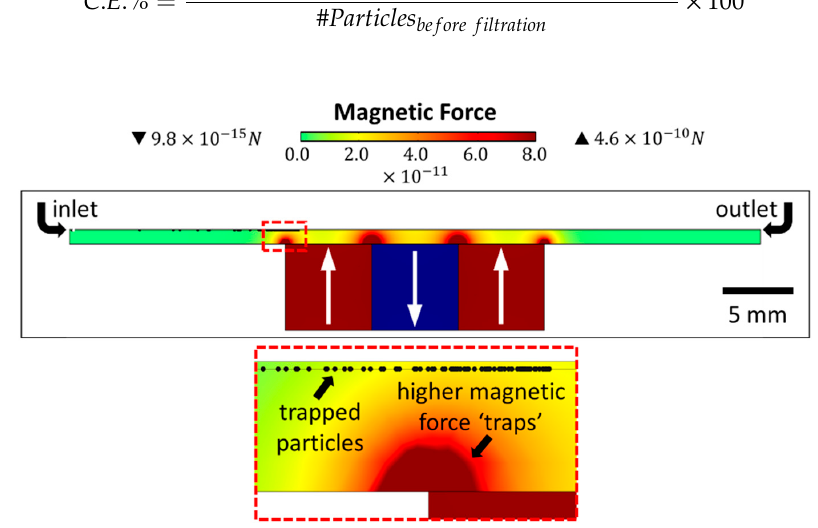
Figure 4. COMSOL geometry used for simulations of the µFMS device, isolating ‘microdisc’ particles with a D hd of 618 nm.